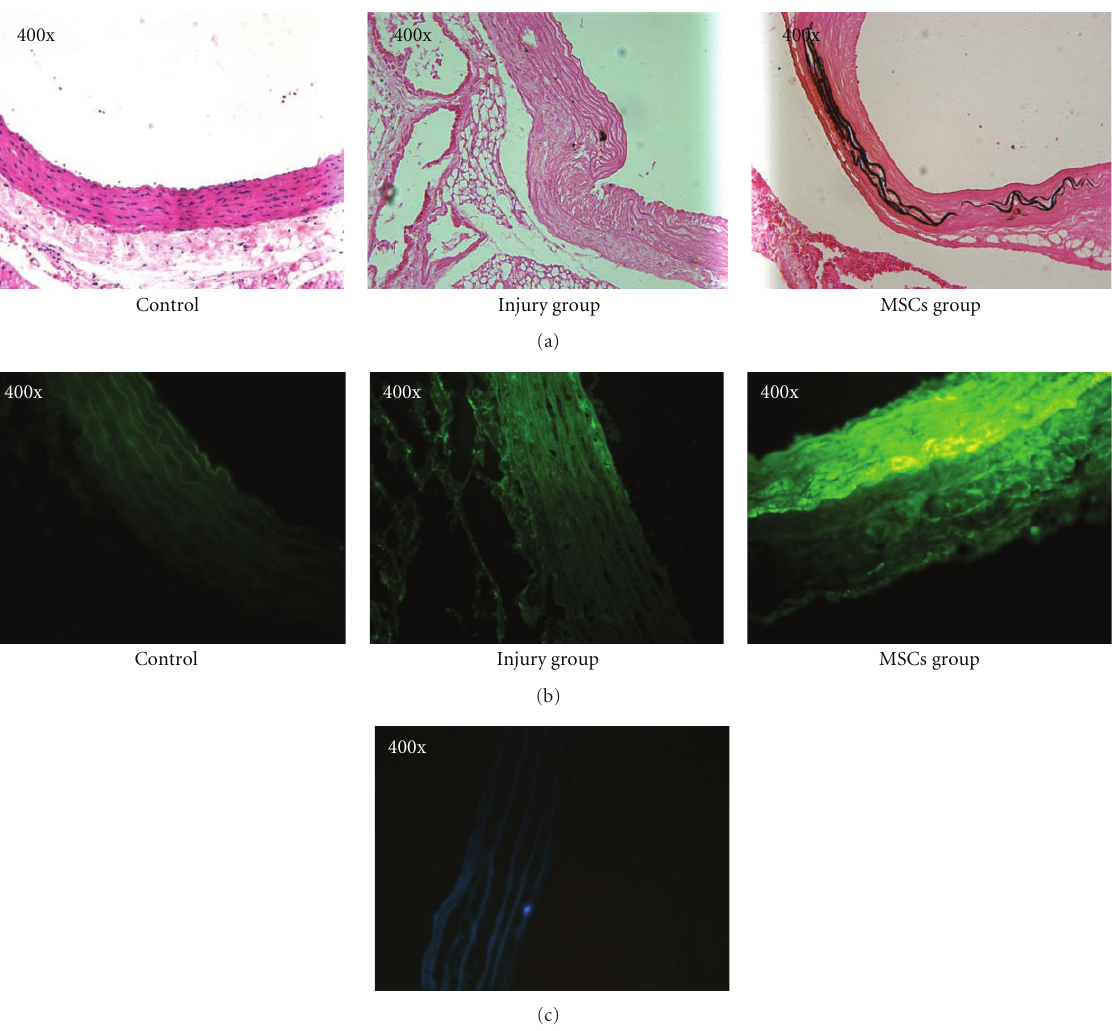
Figure 4: E ff ect of BM-MSCs on vascular calcification after balloon angioplasty and the fate of transferred BM-MSCs. (a) Von Kossa staining was performed to detect vascular calcification in lesions black metallic deposit was obviously visualized in medial layers in MSC group, compared control and injury group. (b) Immunofluorescence staining was performed to determine the expression of BMP-2. Results indicated that upregulated BMP-2 was strongly expressed in the neointimal and medial layers of vascular wall in MSC group, compared Control and Injury groups. (c) Labeled BM-MSCs were homing in the intimal layers at 6 weeks after angioplasty. n = 8 per